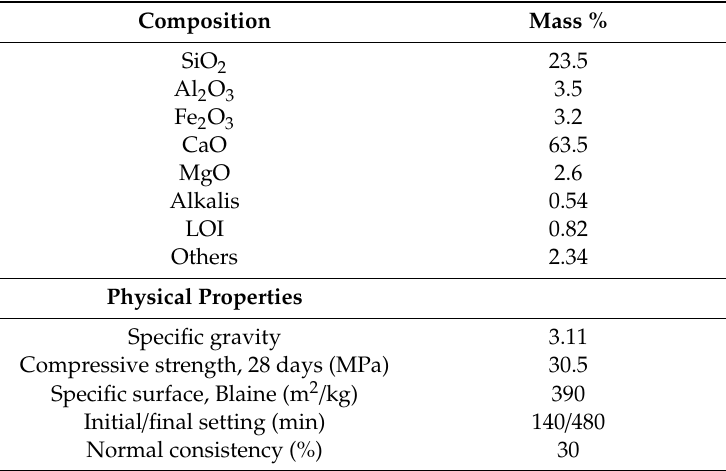
Table 1. Physical properties and chemical composition of OPC.